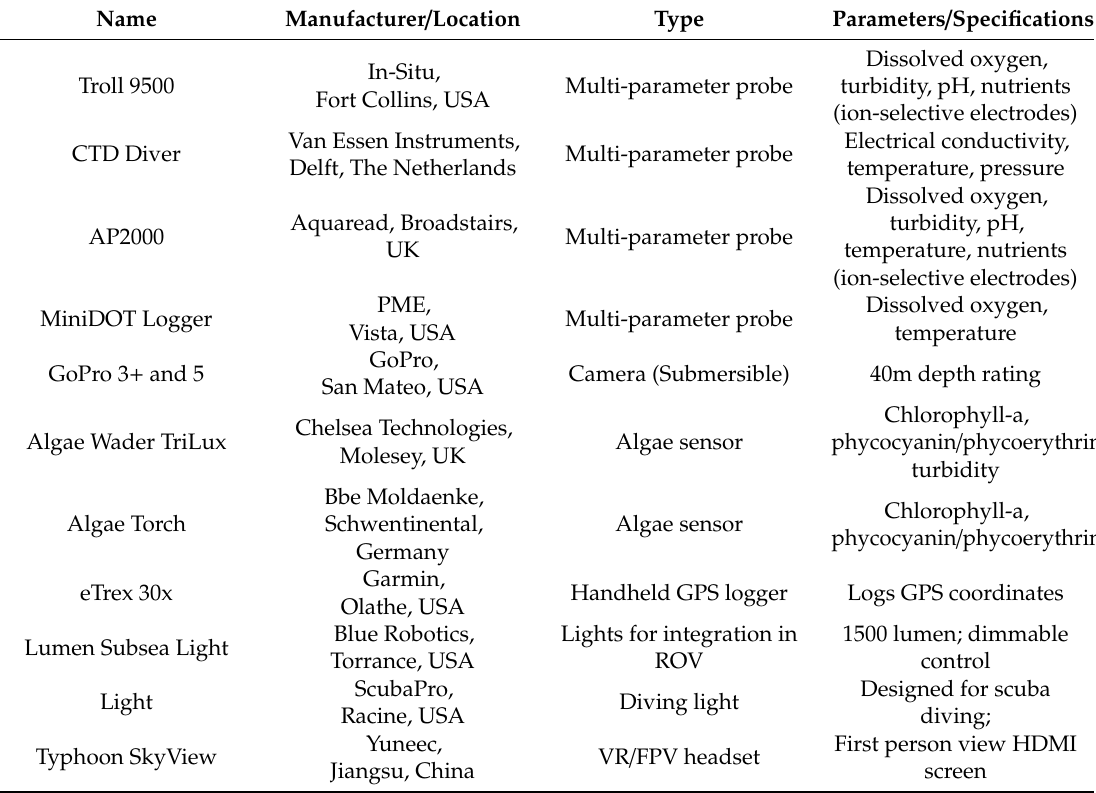
Table 2. List and characteristics of the equipment used on the ROVs.